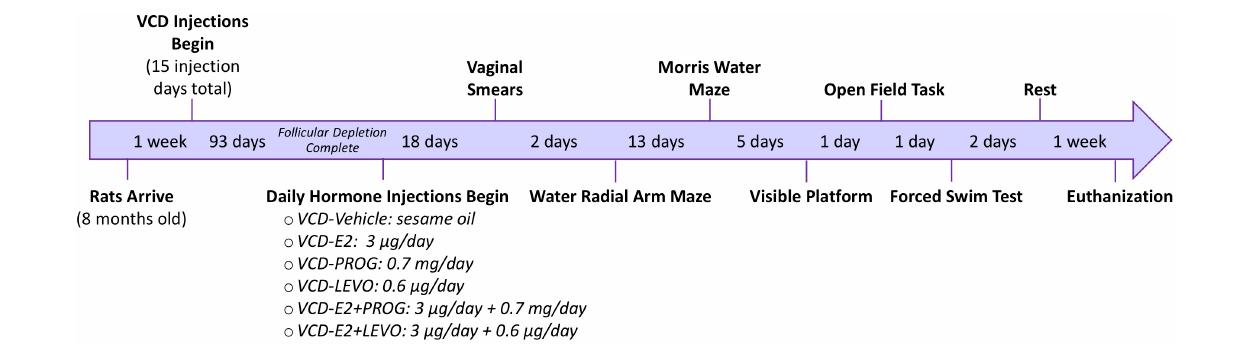
treatments altered body weight in an ovary-intact, follicle- depleted